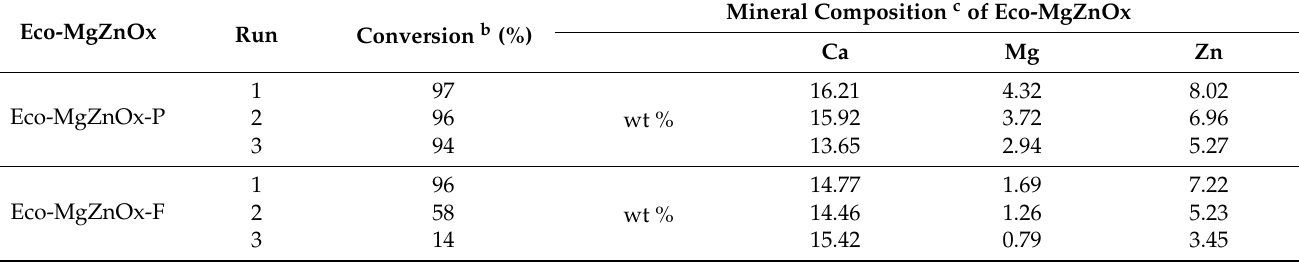
Table 3. Recovery and reuse tests of the Eco-MgZnOx catalysts a